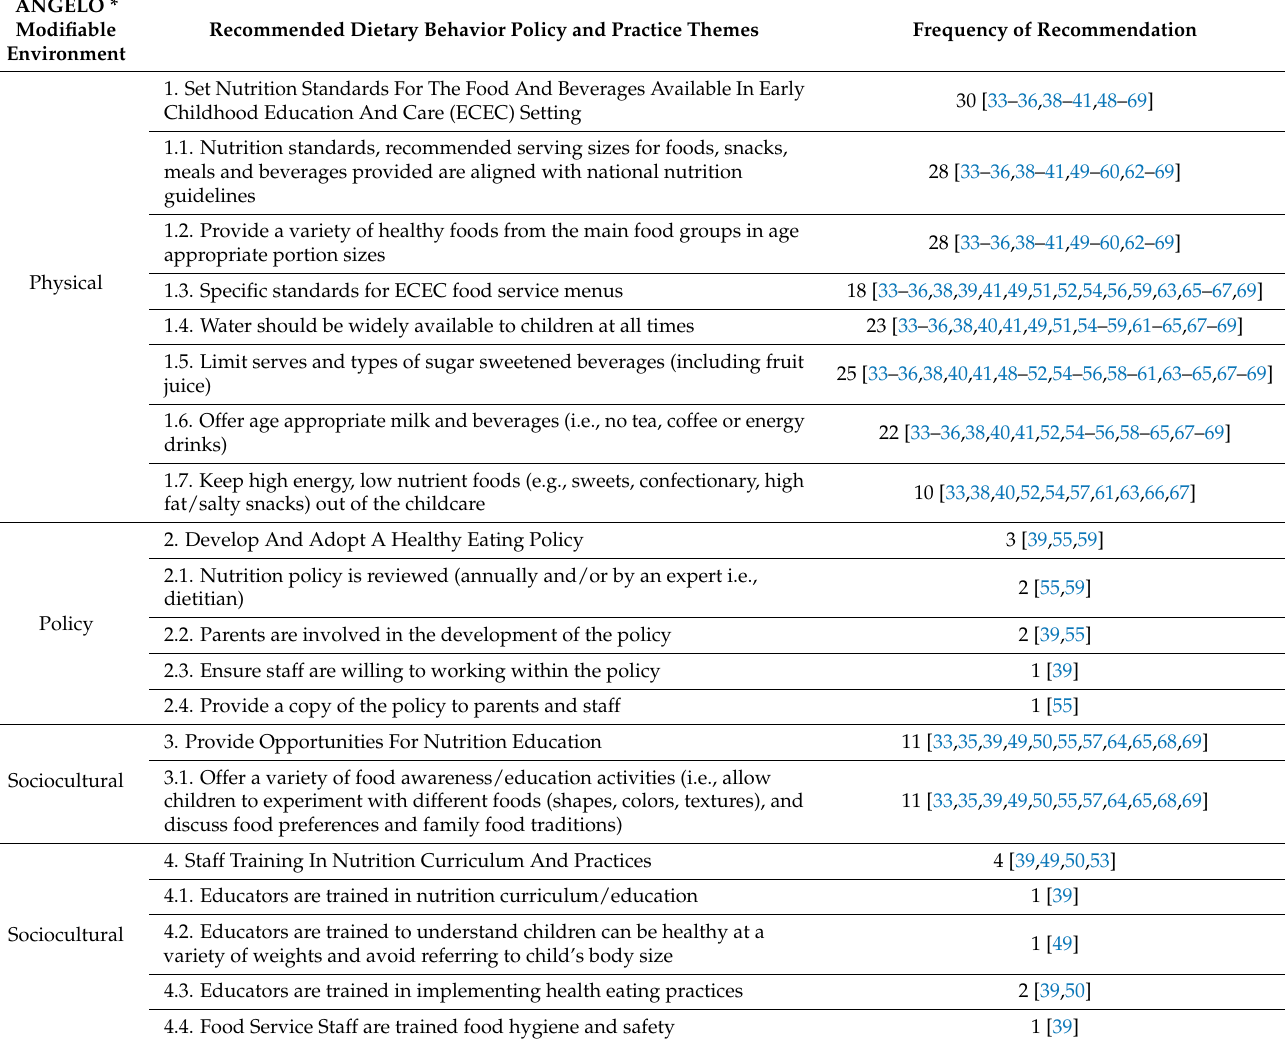
Table 2. Dietary behavior policies and practices within included guidelines ( n =